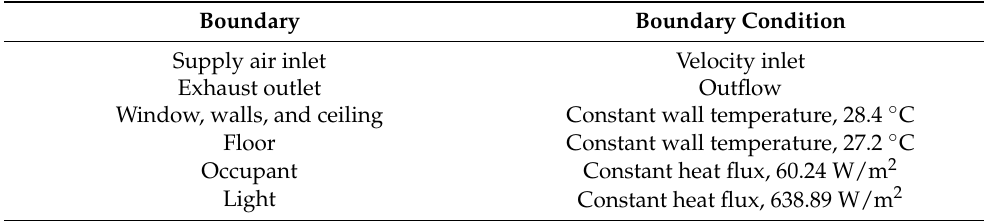
Table 4. Boundary conditions for simulation